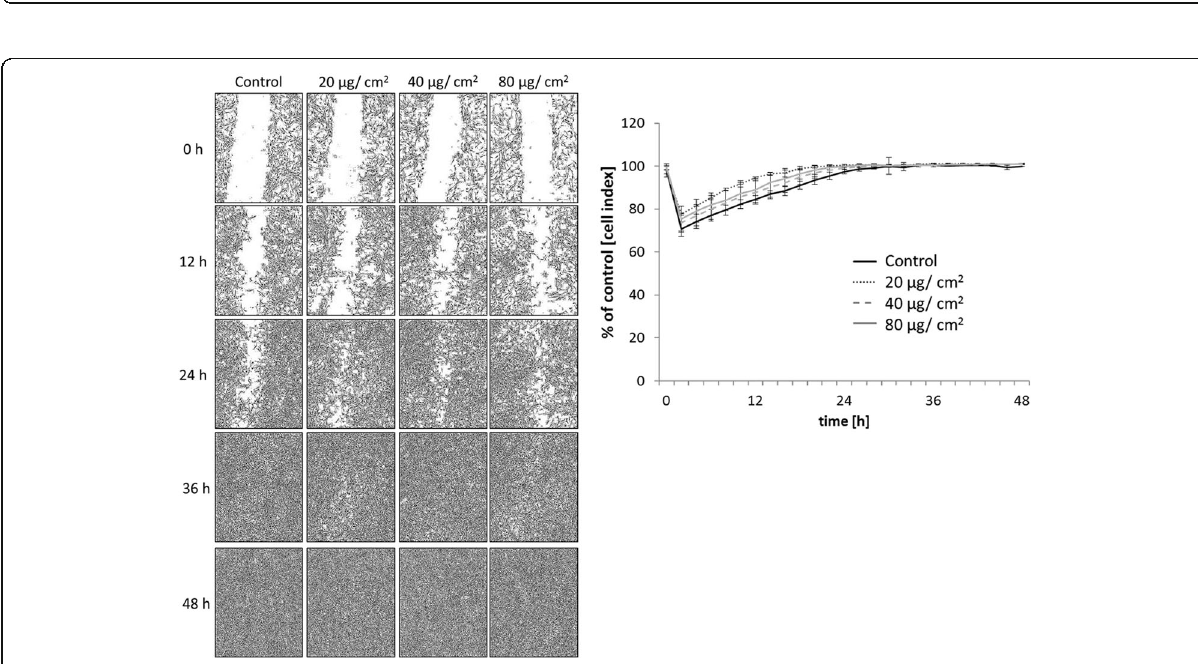
Fig. 3 Cell migration analyzed using scratch assay. In the left panel , cell monolayer was wounded at 0 h and, after 48 h, this scratch was closed under each condition (control, 20, 40, and 80 μ g/cm 2 of SPIONs). In the right panel , confluence measured with Incucyte® revealed that cell migration was not significantly affected by treatment with different concentrations of SPIONs (as indicated). p > 0.05